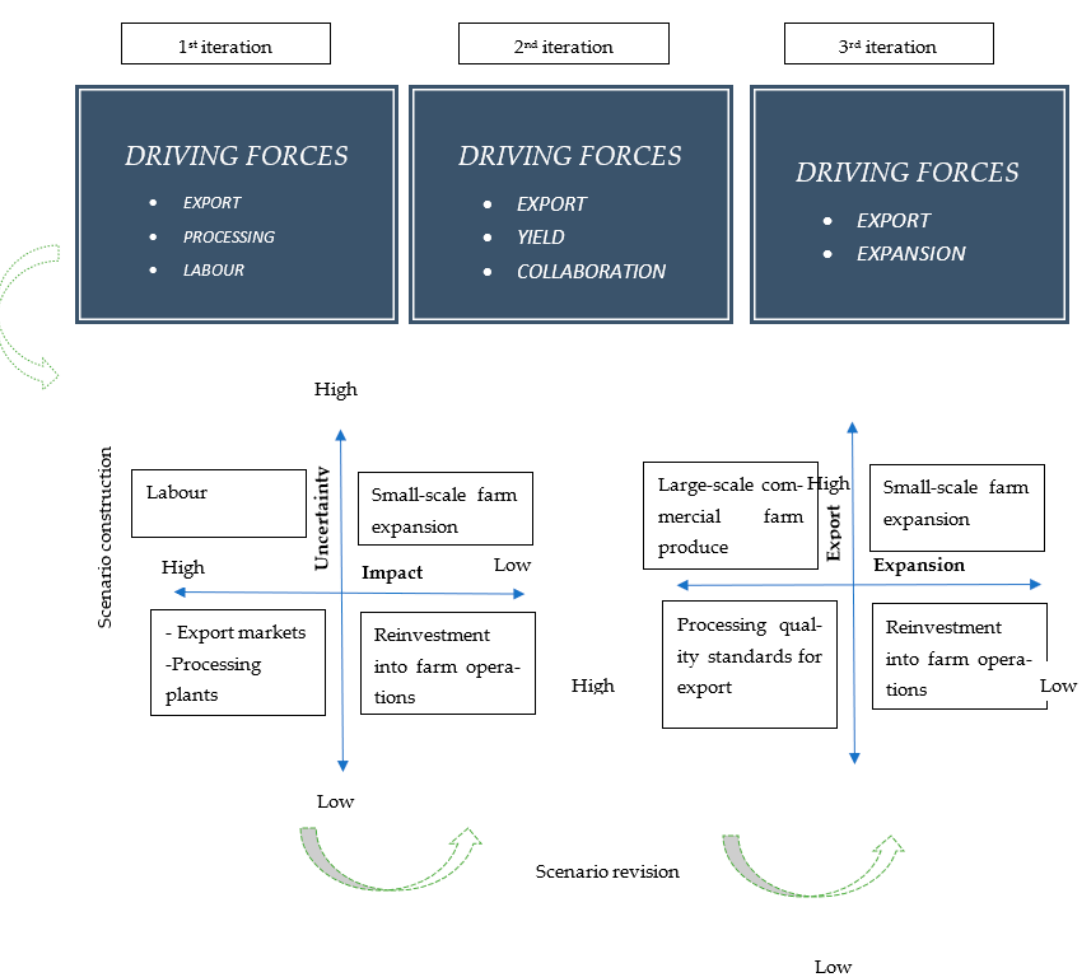
Figure 2. An example of the three iterations of the scenario development using the 2 × 2 quadrant of uncertainty vs. impact used for scenario construction for macadamia nuts based on the key drivers and uncertainties identified from interviews. Adapted with permission from Rameriz et al. [29] 2022. Rafael